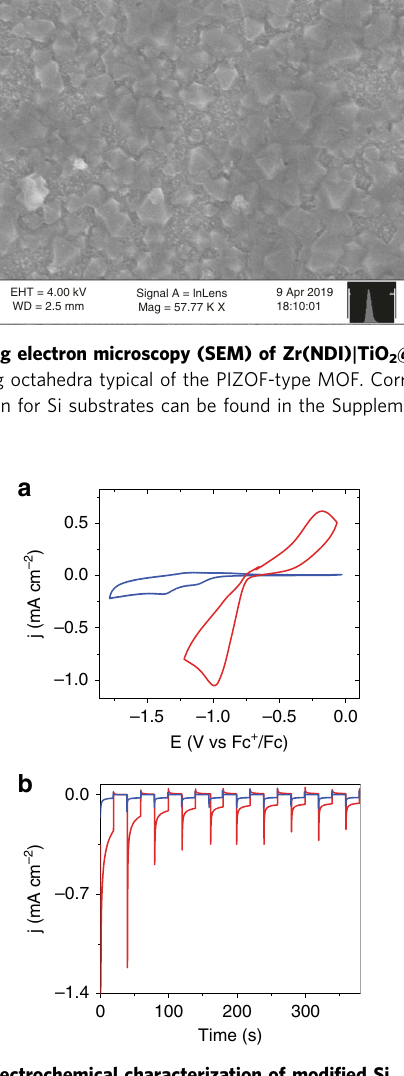
Fig. 4 Photoelectrochemical characterization of modi fi ed Si photocathodes. a Cyclic voltammograms of NDI ∣ TiO 2 @Si (blue) and Zr (NDI) ∣ TiO 2 @Si working electrodes (red) at a scan rate of 100 mV s − 1 with 0.5 M LiClO 4 in DMF as the supporting electrolyte under AM 1.5 illumination. b Chronoamperograms of NDI ∣ TiO 2 @Si (blue) and Zr (NDI) ∣ TiO 2 @Si (red) working electrodes under chopped light illumination at a potential of − 1.1 V vs. Fc + /0 with 0.5 M LiClO 4 in DMF as the supporting electrolyte in the presence of 1 mM tris(2,2 ′ -bipyridine)cobalt (III) tris(hexa fl fi lm on FTO and illuminated NDI ∣ TiO 2 @Si also clarify the role of the TiO 2 layer, which, in our case, serves solely as a tunneling barrier and does not facilitate charge separation or stabilization.